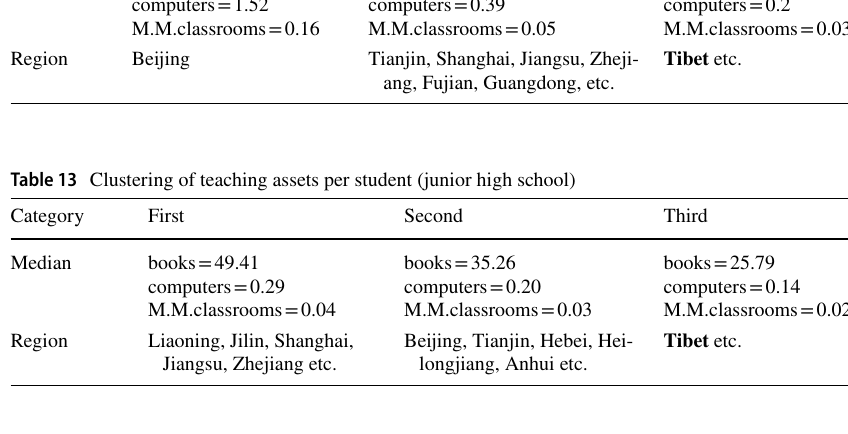
Table 14 Clustering of teaching assets per student (primary school) Category